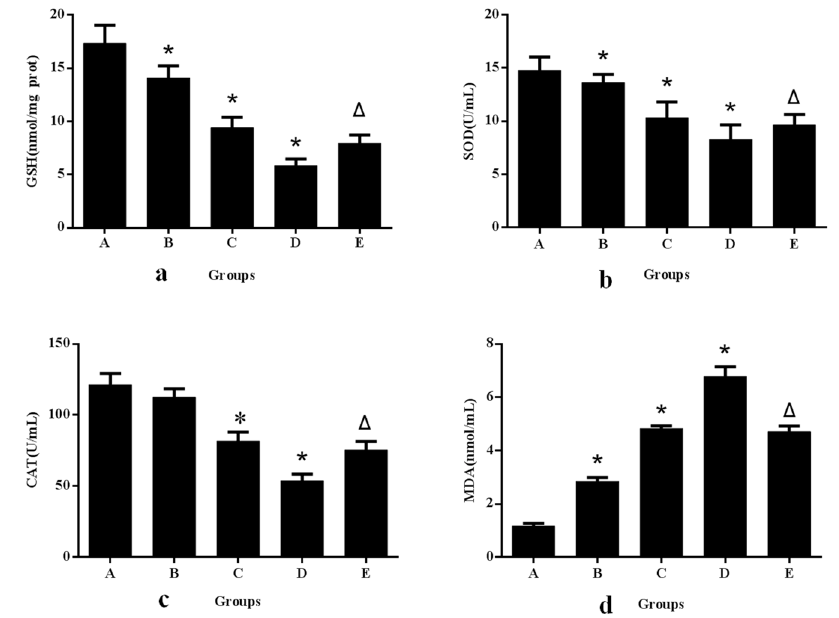
Figure 2. Changes in GSH, SOD, CAT and MDA levels after exposure of hepatocytes to aniline for 24 h. A. 0 µ g/mL; B. 2.50 µ g/mL; C. 5.0 µ g/mL; D. 10.0 µ g/mL; E. 10.0 µ g/mL + 20 mmol/L NAC. A. 0 μ g/mL; B. 2.50 μ g/mL; C. 5.0 μ g/mL; D. 10.0 μ g/mL; E. 10.0 μ g/mL + 20 mmol/L NAC. Each data